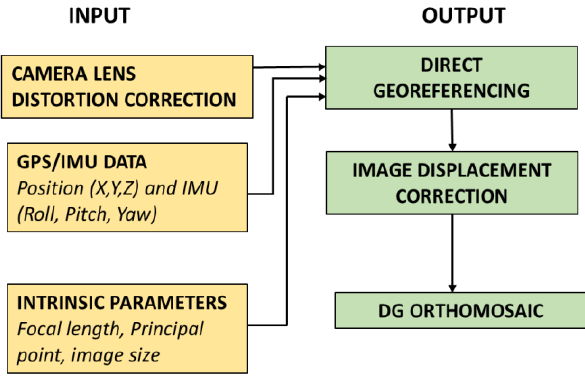
Figure 3. A flow diagram showing the Direct Georeferencing process of reconstructing 2D